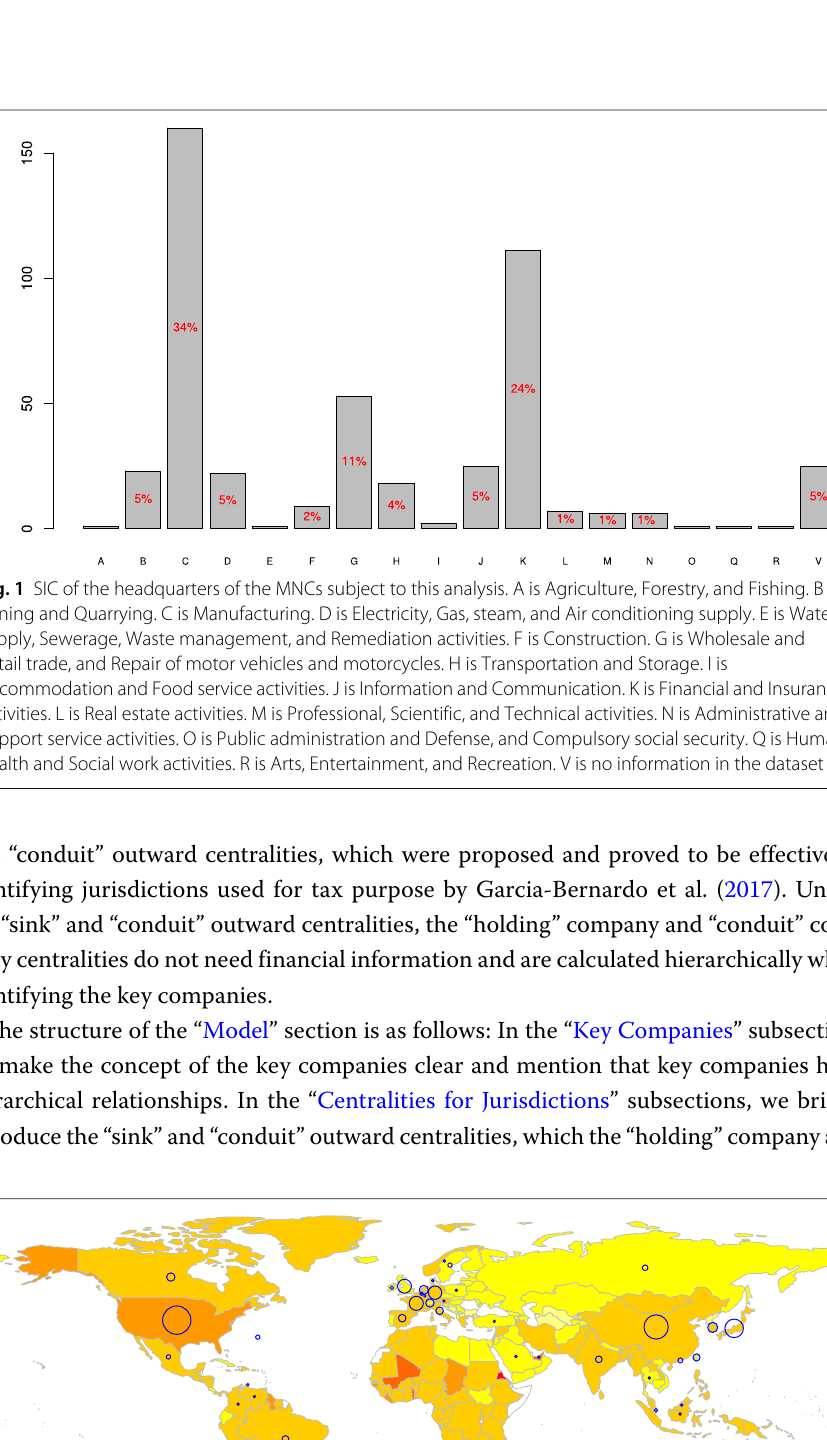
Fig. 2 Geographical distribution of the headquarters of the MNCs subject to this analysis and statutory corporate tax rate. The size of the circles represents the number of headquarters of the MNCs subject to this analysis and the depth of the color indicates the statutory corporate tax rate, by the